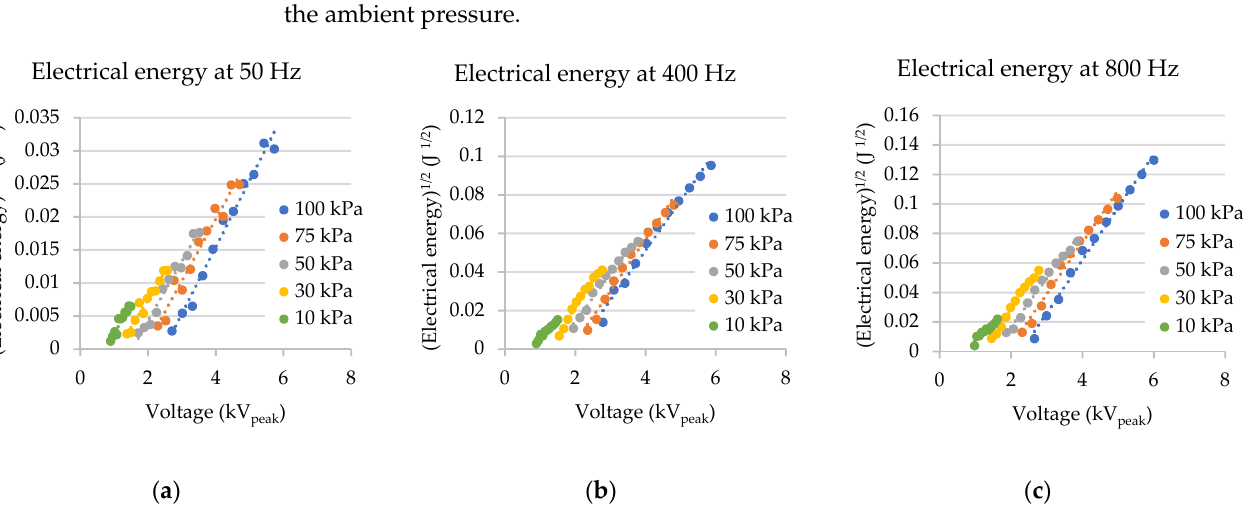
Figure 8. Experimental results of the ETFE aeronautic wires. Normalized discharge intensity versus voltage for air pressures ranging from 10 to 100 kPa. ( a ) 50 Hz, ( b ) 400 Hz, ( c ) 800 Hz.